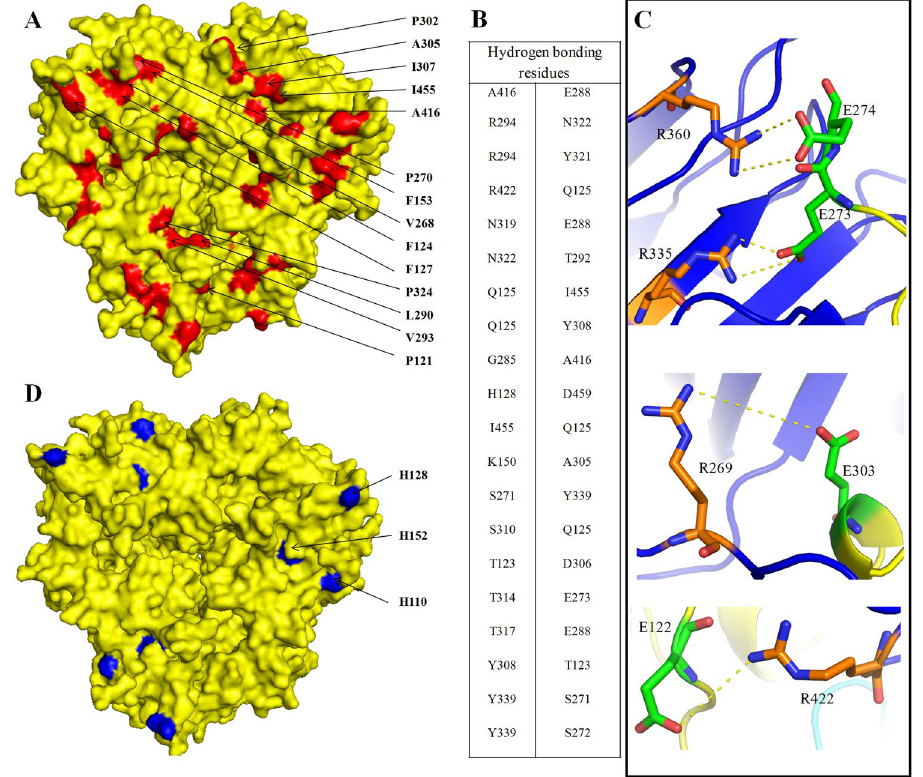
Figure 2. Protein-protein interaction involved in the formation of WTG hexamer. ( A ) The surface view of WTG trimer (yellow) showing the hydrophobic residues (red) involved in interaction with residues of another trimer. ( B ) The residue pairs of chain A and D involved in hydrogen bond formation. The N-terminal of chain A is stacked over C-terminal of chain D during hexamer formation. ( C ) The key residues involved in salt bridge formation between the trimers. Residues from chain A (orange sticks) and residues from chain D (green sticks). The interactions are shown via yellow dashed lines. ( D ) Residues His110, His128 and His152 present on the surface become more positively charged at acidic pH and result in dissociation of IE face. All residues have been shown in ball and stick